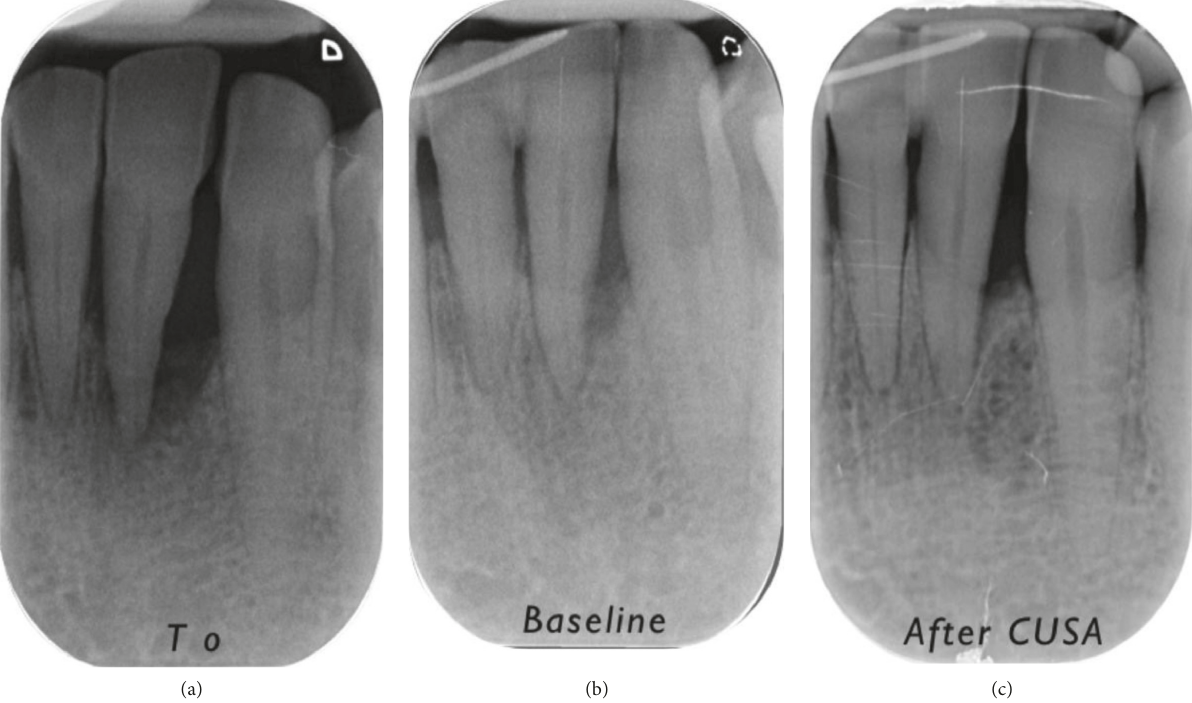
Figure 7: Progression of X-rays showing bone remineralization. Baseline is 12 months after (a) T0. In this case, the PD decreased from 8mm ((b) baseline) to 3 mm (6 months (c) after CUSA). The CAL gain was 4 mm (from 10mm to 6mm).